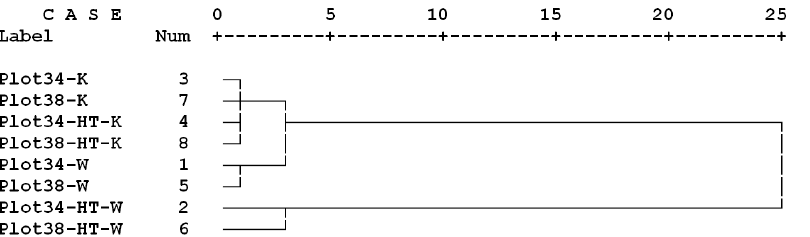
Figure 5. Cluster analysis of the eight treatments (consisting of the two plots with different spacings and the four treatments of each) based on liquid permeability determined by the first drop from the bottom of the RILEM tube, and by the dropping of the water column in the tube in five different stages (Plot34 = plot with spacing 3 × 4 m; Plot38 = plot with spacing 3 × 8 m; K = permeability measured by kerosene; W = permeability measured by water; HT = heat-treated specimens). Table 1. Regression analysis between specific gas permeability and liquid permeability as determined by the first drop, and by the time it took for the water column to drop in the RILEM tube, in Populus nigra var. betulifolia with 3 × 4 m spacing (A) and 3 × 8 m spacing